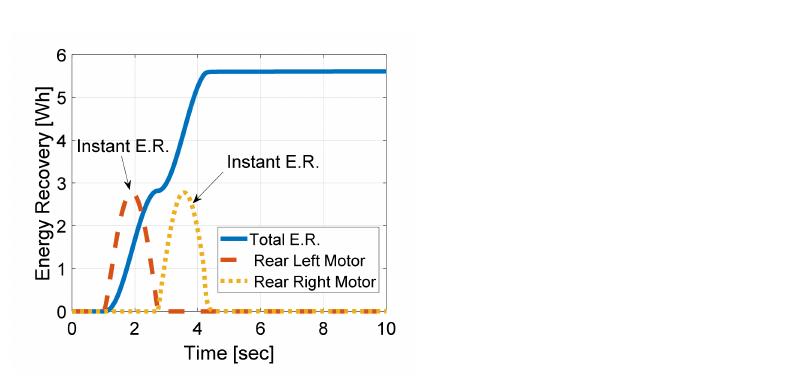
Figure 7. Total and instant energy recovery during regenerative stability